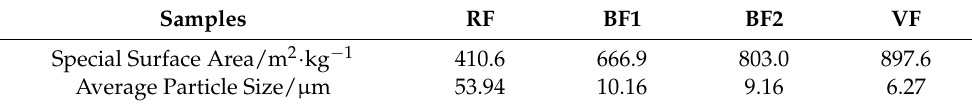
Table 3. Special surface area and average particle size of fly